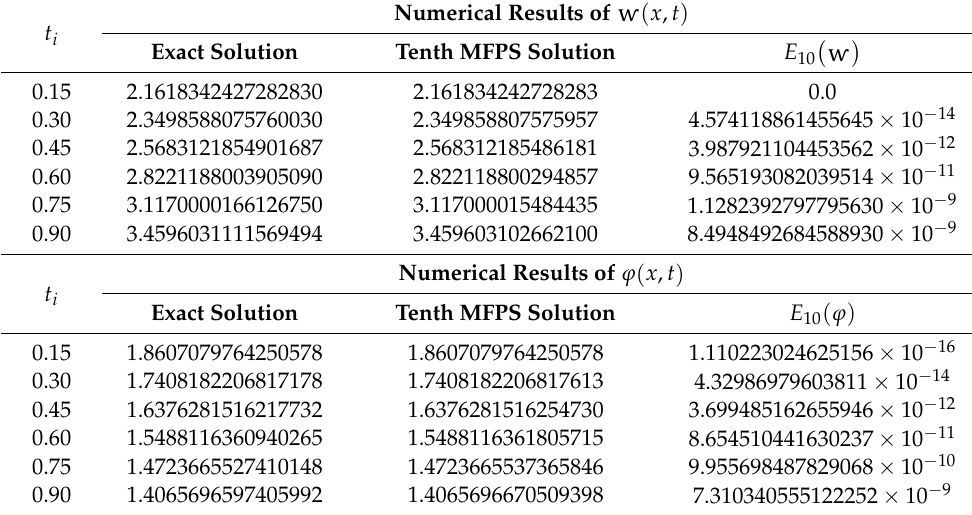
Table 1. Numerical results for Example 1 at α = 1 and n = 10 .